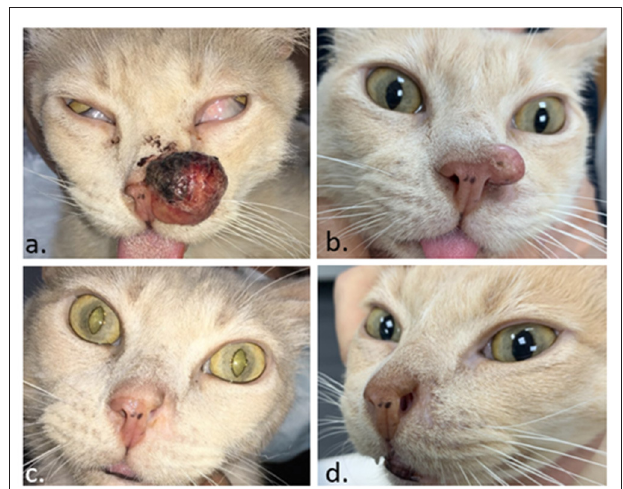
FIGURE 8 | Feline patient with a squamous cell carcinoma in the nose. In (a) the day of the ECT. In (b) 1 month later, the tumor regrew, and a second ECT session was performed. In (c) , a complete response was obtained 1 month after the second ECT. In (d) , the patient remains disease-free 4 months later.